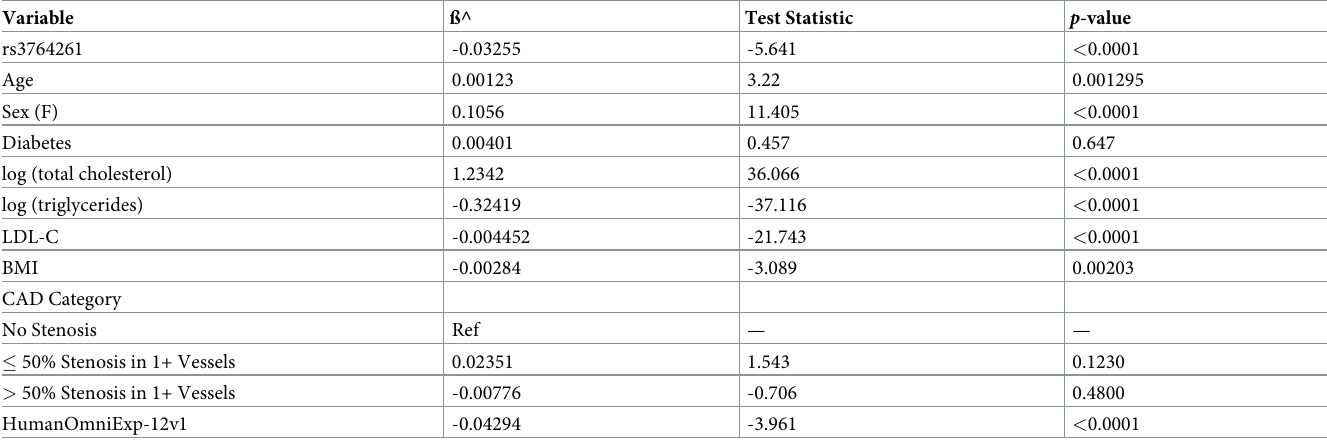
Table 3. Regression coefficients from adjusted model